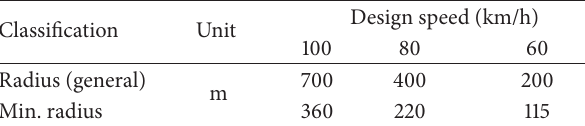
Table 11: Scoring method according to mean lane